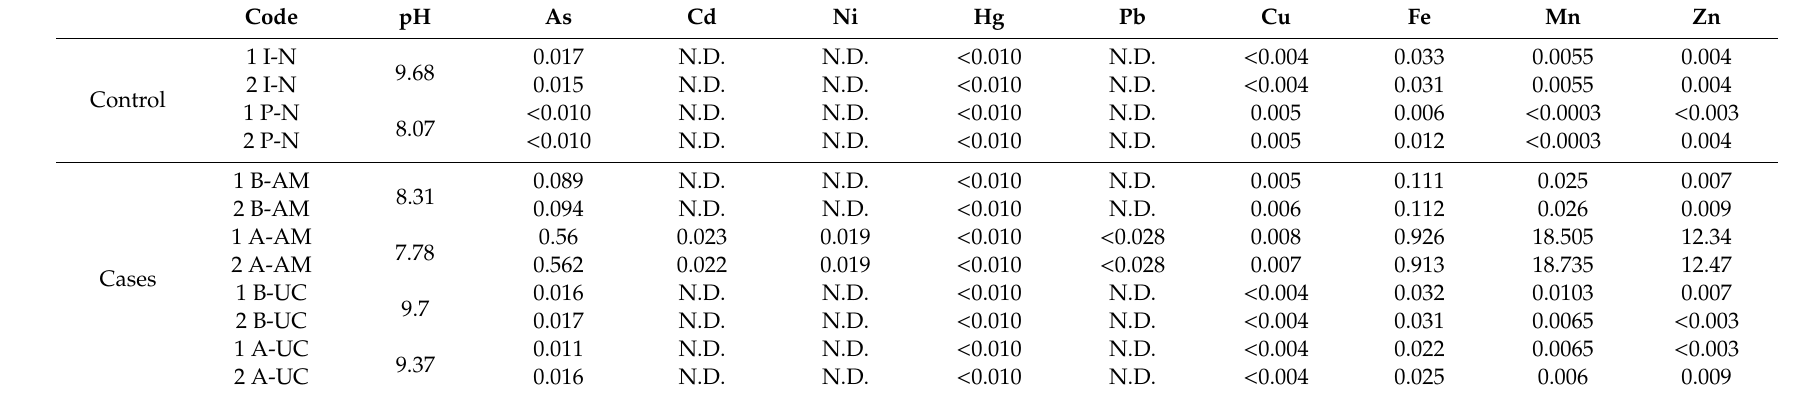
Table A3. Concentration (mg L − 1 ) of total metals in water samples in this research in Cunas